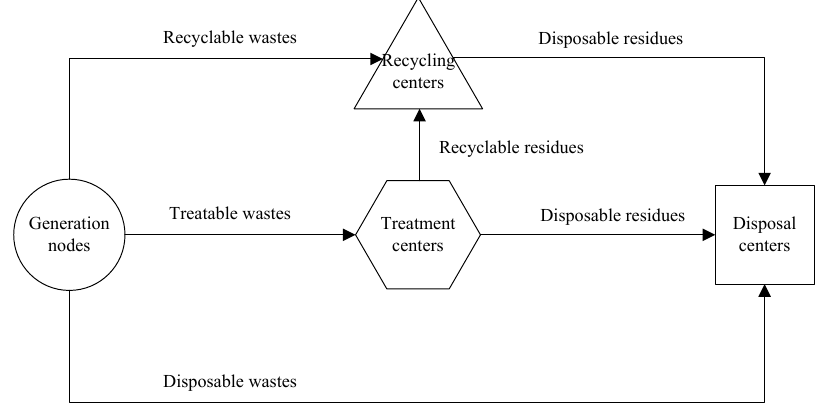
Figure 1. Regional hazardous waste management